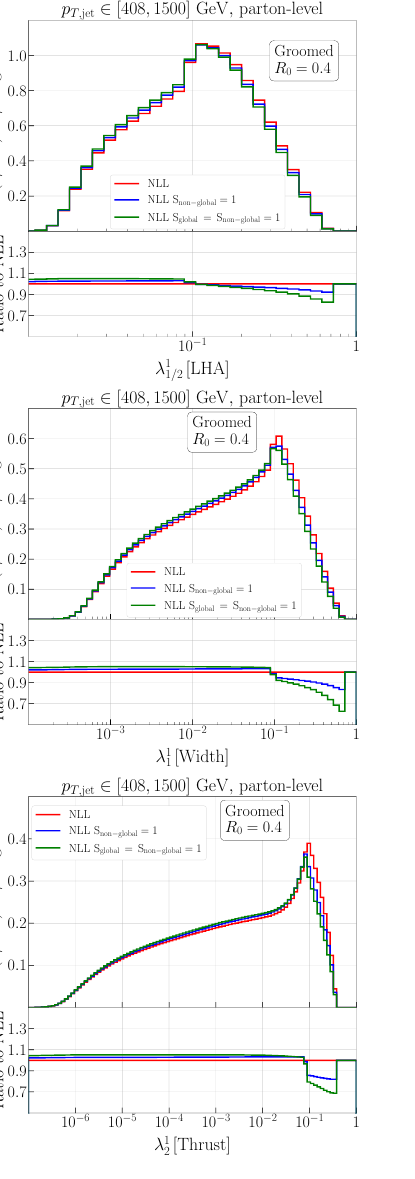
Figure 15 . Same as figure 4 but with soft-drop grooming using z cut = 0 . 1 , β = 0